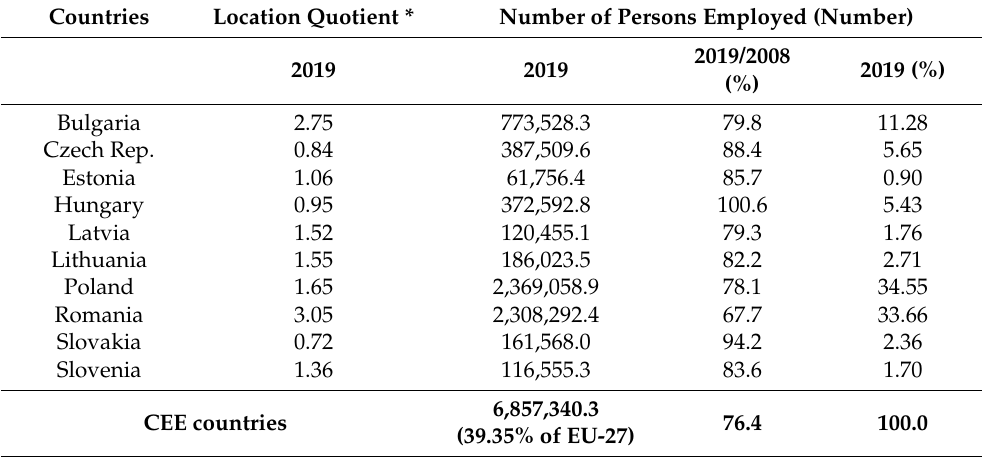
Table 1. Number of persons employed in 10 CEE countries—bioeconomy